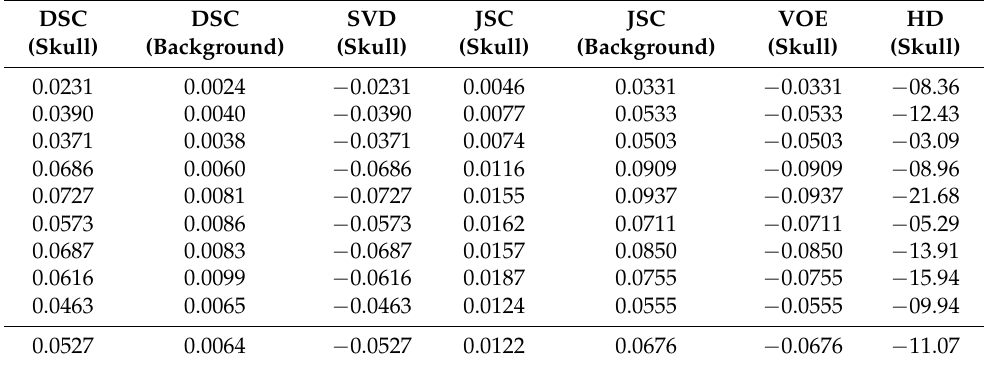
Table 6. Differences between Dataset 2 minus Dataset